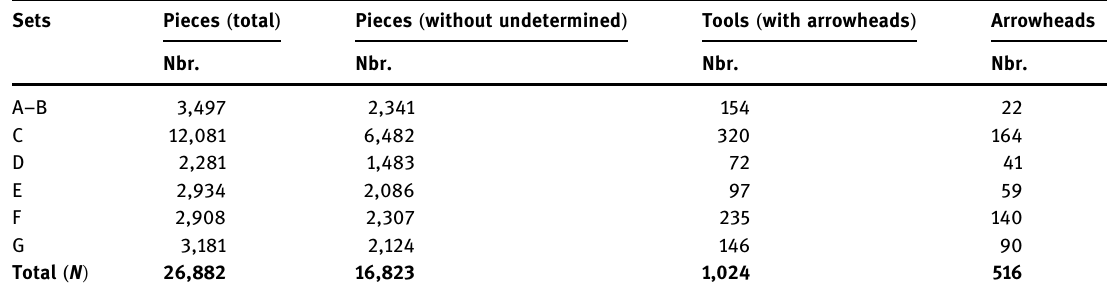
Table 1: Count of lithic pieces for each set in our study area Sets Pieces ( total ) Pieces ( without undetermined ) Tools ( with arrowheads ) Arrowheads